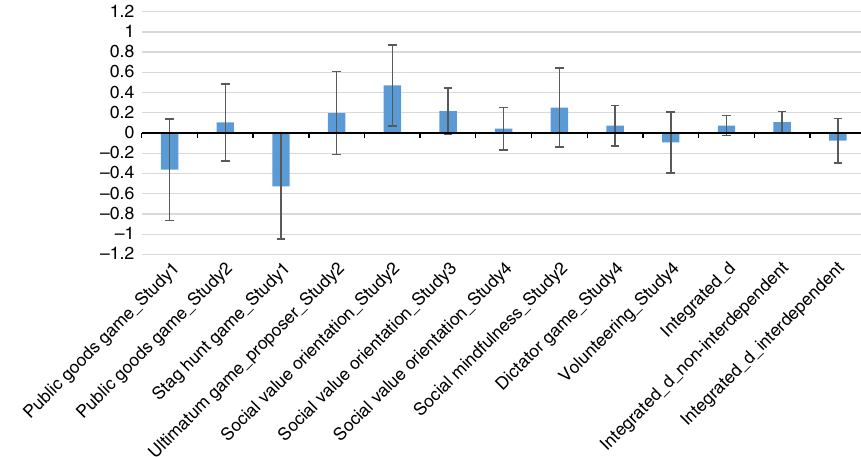
Fig. 1 Effect sizes d of the effects of hunger on prosociality. Positive values indicate effects in favor of a hypothesis that hunger decreases prosociality. Negative values indicate increased prosociality when hungry. Non-interdependent tasks: SVO, Social Mindfulness, DG, Volunteering. Interdependent tasks: PGG, SHG, UG. Effect size calculation was based on Lipsey and Wilson ’ s formulas 52 . Error bars indicate 95% con fi dence